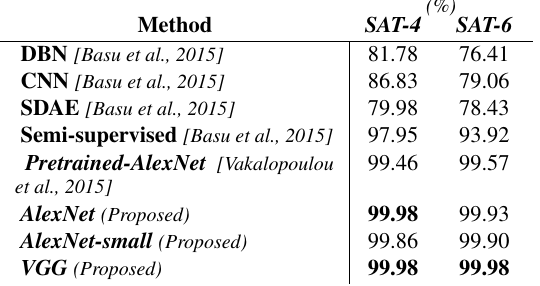
Table 3: The resulting overall accuracy rates after the application of different learning frameworks for both datasets.